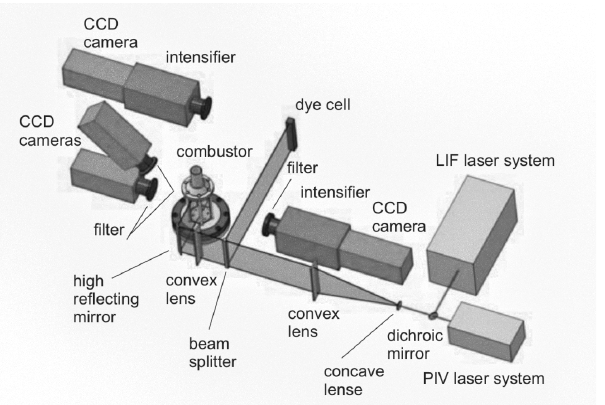
Figure 4. Alignment of experimental tools for PIV, OH-PLIF, and OH* chemiluminescence measure- ments. Courtesy of